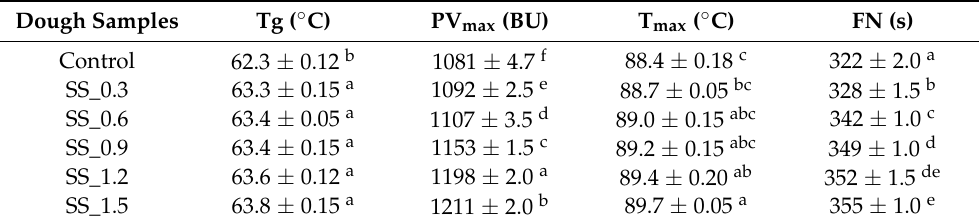
Table 3. Viscometric rheological properties of the dough samples with different levels of sea salt with low sodium content (SS) additions.